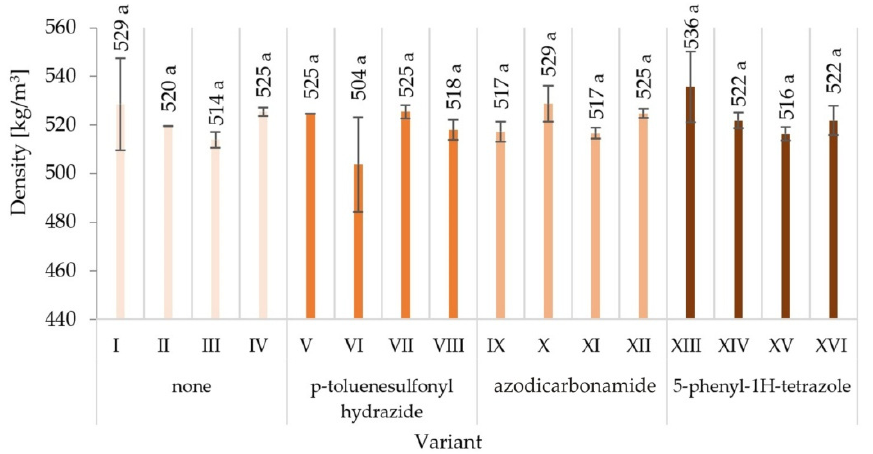
Figure 1. Density of particleboards produced (means and standard deviation, a, b, c, . . . — homogeneous groups determined by the Tukey test; different letters denote a significant difference; means followed by the same letter do not statistically differ from each other).